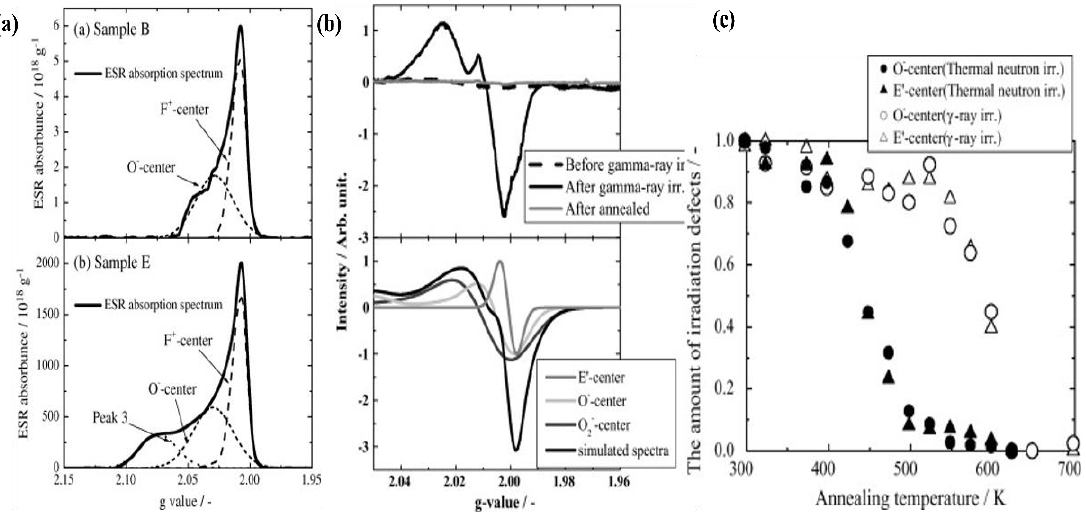
Figure 9. ( a ) ESR absorption spectra for sample B and sample E. Reprinted with permission from ref. [105]. ( b ) Typical ESR spectra for Li 2 TiO 3 before and after gamma-ray irradiation at 45 kGy, and that with gamma-ray irradiation after annealing at 673 K for 3000 s. Reprinted with permission from ref. [104]. ( c ) The normalized intensities for E’-center and O − -center for the thermal neutron and the γ − ray irradiated samples as a function of annealing temperature. Reprinted with permission from ref. [106].